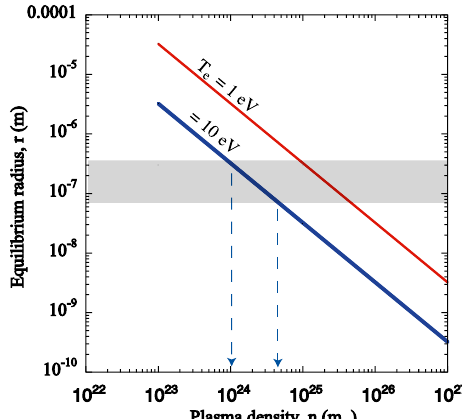
FIG. 16. Equilibrium radius from surface tension and plasma pressure for two electron temperature plasmas compared with dimensions from Ref. [13] and other measurements in the range ( (cid:2) 80 – 350 (cid:8) m ), see Fig.